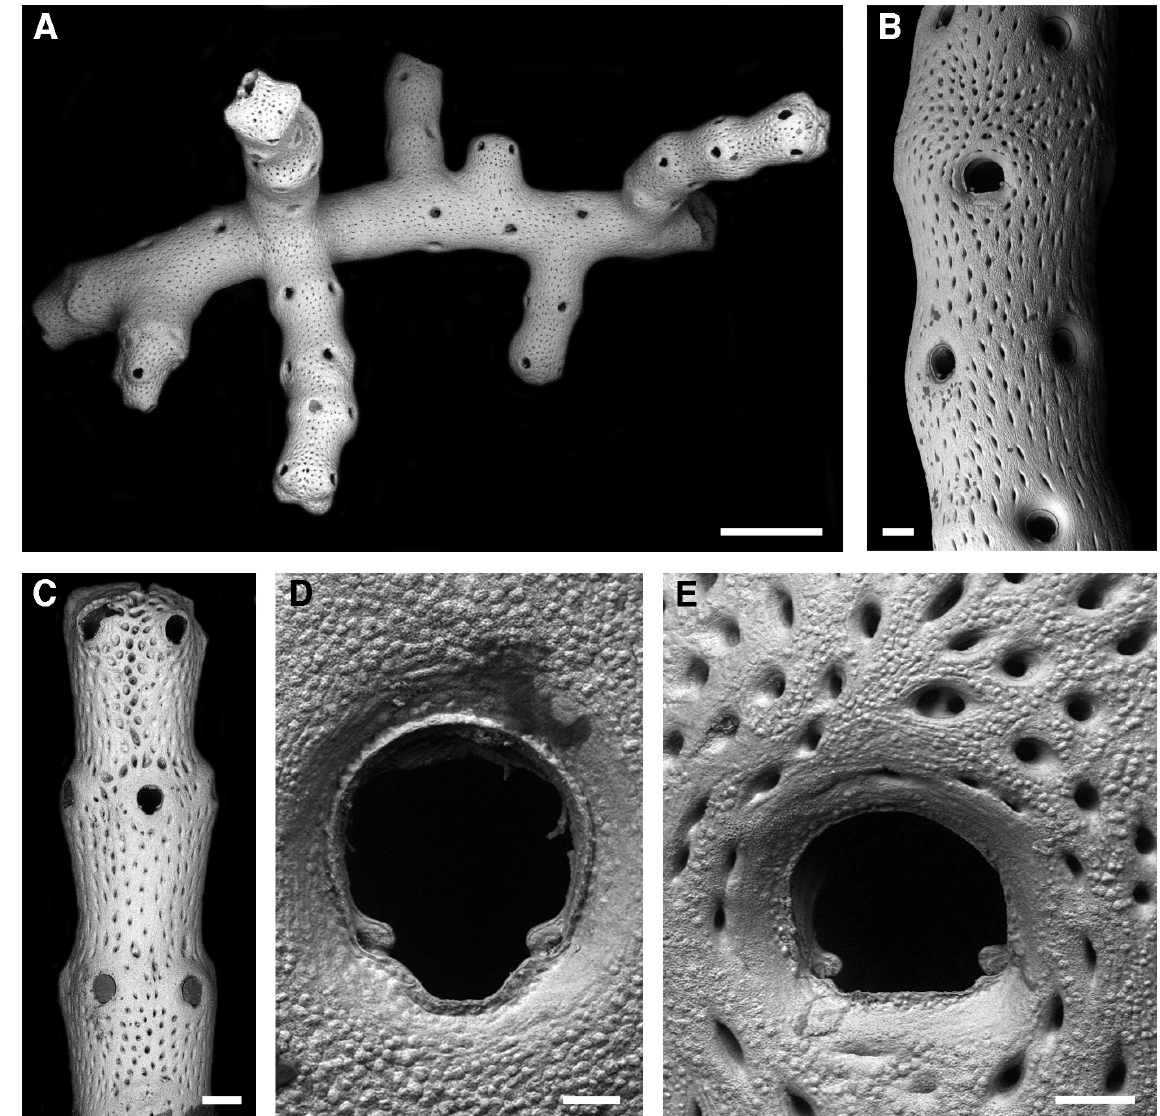
Fig. 4. Myriapora bugei d’Hondt, 1975. A . Colony fragment with closely spaced branches bifurcating at a 90° angle from the main branch (MnHn iB-2013-3, lectotype). B . Branch segment with one whorl of fertile zooecia at top, identified by the larger dimorphic orifice and the radial arrangement of pseudopores (MnHn iB-2013-2, paralectotype). C . Distal branch with early ontogenetic autozooecia (MnHn 7481, paralectotype). D . Close-up of an autozooecial orifice (MNHN IB-2013-2, paralectotype). E . The dimorphic orifice of a maternal zooecium (MNHN IB-2013-2, paralectotype). Scale bars: A = 2 mm; B = 200 µm; C = 300 µm; D = 50 µm; e = 100